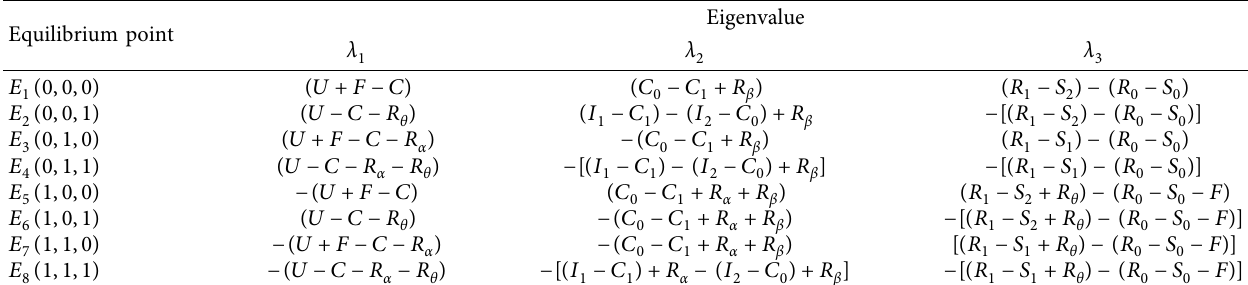
Table 3: Equilibrium points and eigenvalues of the evolutionary